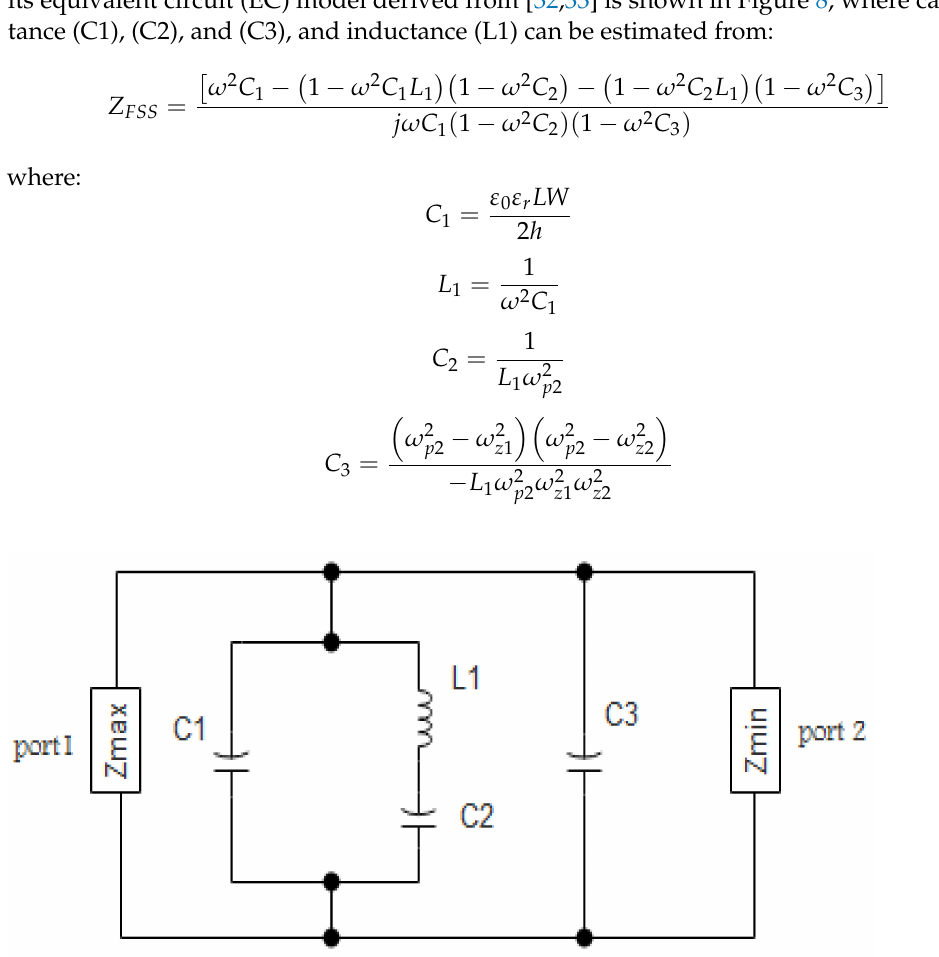
Figure 8. EC model of the FSS.